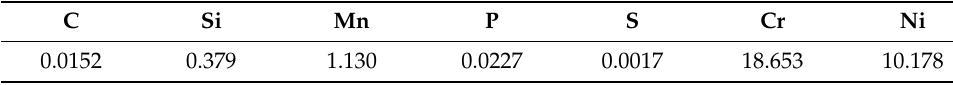
Table 1. Chemical composition of 304L stainless